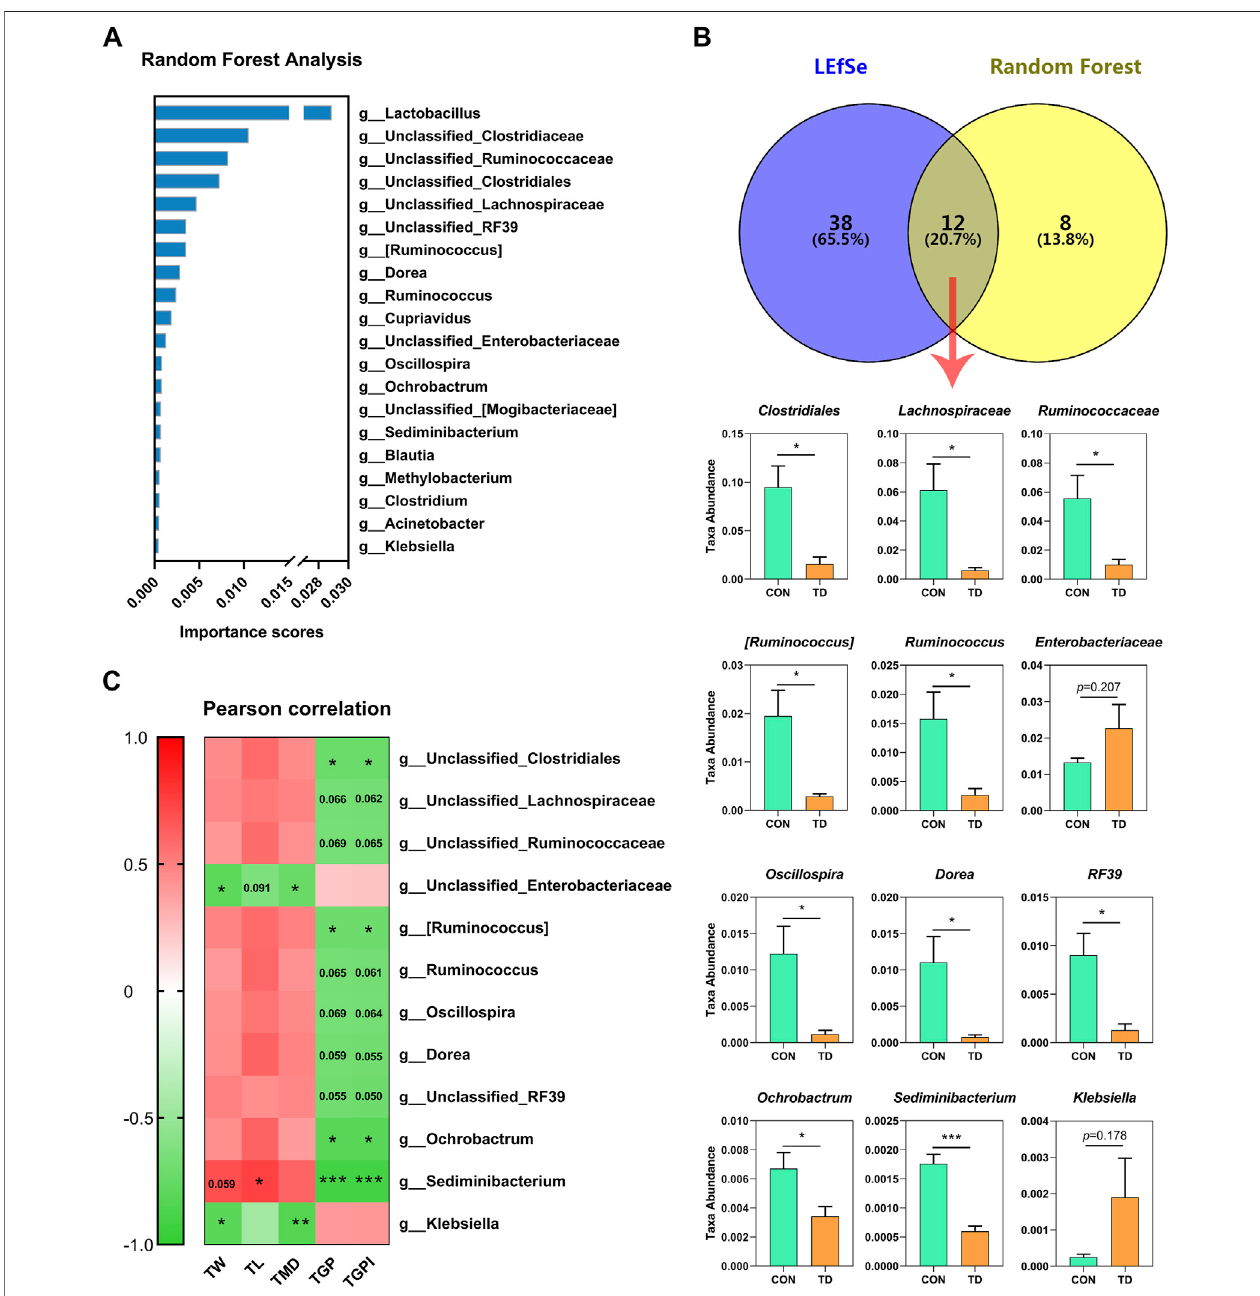
FIGURE 4 | Analysis of differential fecal microbiota in broiler chickens with TD. (A) Random forest analysis on fecal microbiome of CON and TD groups of broiler chickens.The y -axis,fromtoptobottom,displaysthetaxa(TOP20)rankedbytheirimportance(MeanDecreaseAccuracy)forthegroupclassi fi cation. (B) Vennanalysis was performed to screen differential fecal microbiota through LEfSe and random forest model. The overlapping part of the Venn diagram represents the number of differentialfecalmicrobiotaincommonbetweengroups,andstatisticalanalysiswasperformedontherelativeabundancesofthetwelvedifferentialbacterialfamilies betweengroupsandsigni fi cantlydifferentintermsofabundancebytheStudent ’ s t -test(N=4).Theasterisksindicatestatisticallysigni fi cantdifferencesandcorrespond to p < 0.05 (*) and p < 0.001 (***). (C) Pearson correlation analysis between the differential fecal microbiota and tibia-related parameters of broiler chickens with TD. The asterisks indicate statistically signi fi cant differences and correspond to p < 0.05 (*), p < 0.01 (**), and p < 0.001 (***). A p -value higher than 0.05 ( > 0.05) represents not statistically signi fi cant.